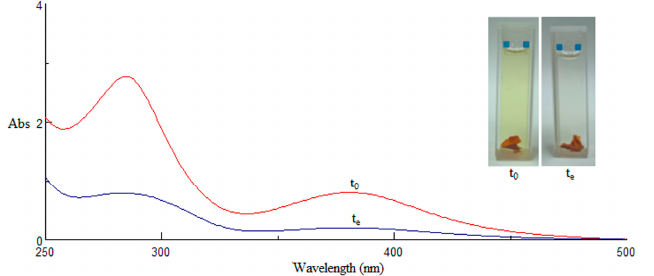
Figure 7. UV-visible spectra of 100 mg L − 1 of Pd(II) solution at pH 4.1 (sodium buffer acetate 0.1 M) incubated with Pd-IAzoCsM and registered immediately after the addition of the membrane (t 0 ) and at the equilibrium time, t e (18 h), and their corresponding photographs.